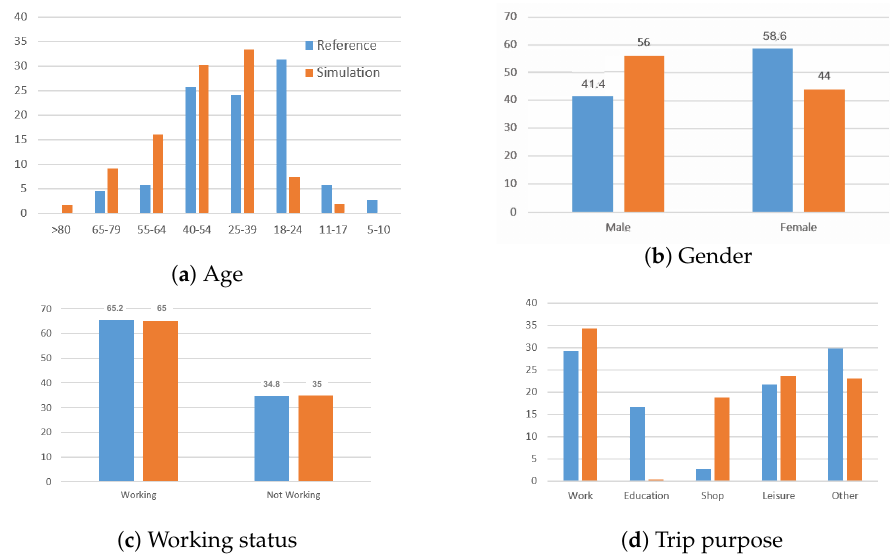
Figure 7. Sociodemographic characteristics of users of the PV + PT alternative and its trip